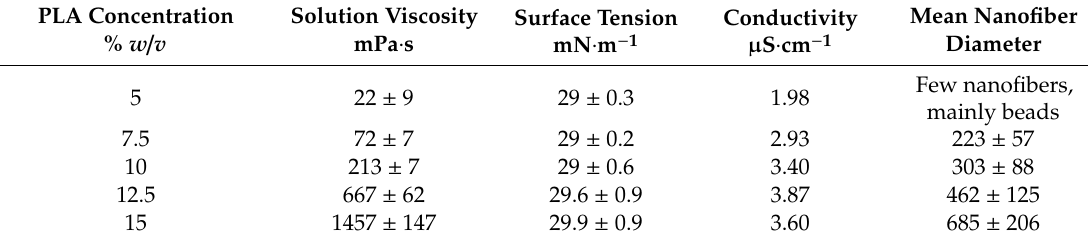
Figure 3. Concentration e ff ect on nanofiber morphology; SEM of PLA nanofibers at concentrations, 8% w / v ( a ), 10% w / v ( b ), 12.5% w / v ( c ), 15% w / v ( d ), 15% w / v ( e ) with CTAC-MMT. Table 2. E ff ect of polymer concentration on solution viscosity, surface tension, conductivity, and fiber diameter